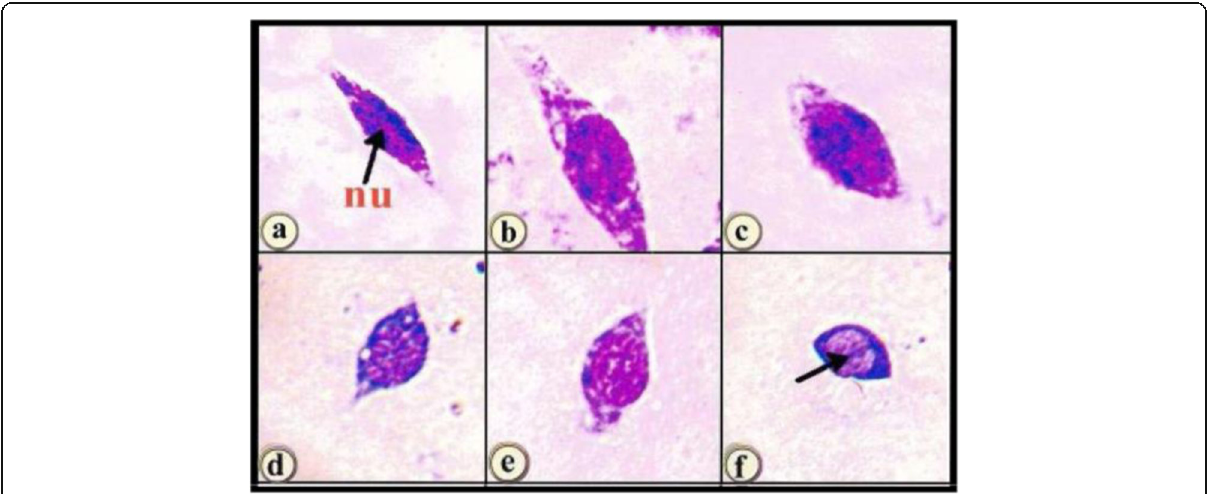
Fig. 5 Morphological changes in spindle cells ( x = 1600). a Normal: spindle shaped cells with spindle nucleus (arrow). b 40Gy, c 100Gy, d BA2 20 IJs/ml, e BA2